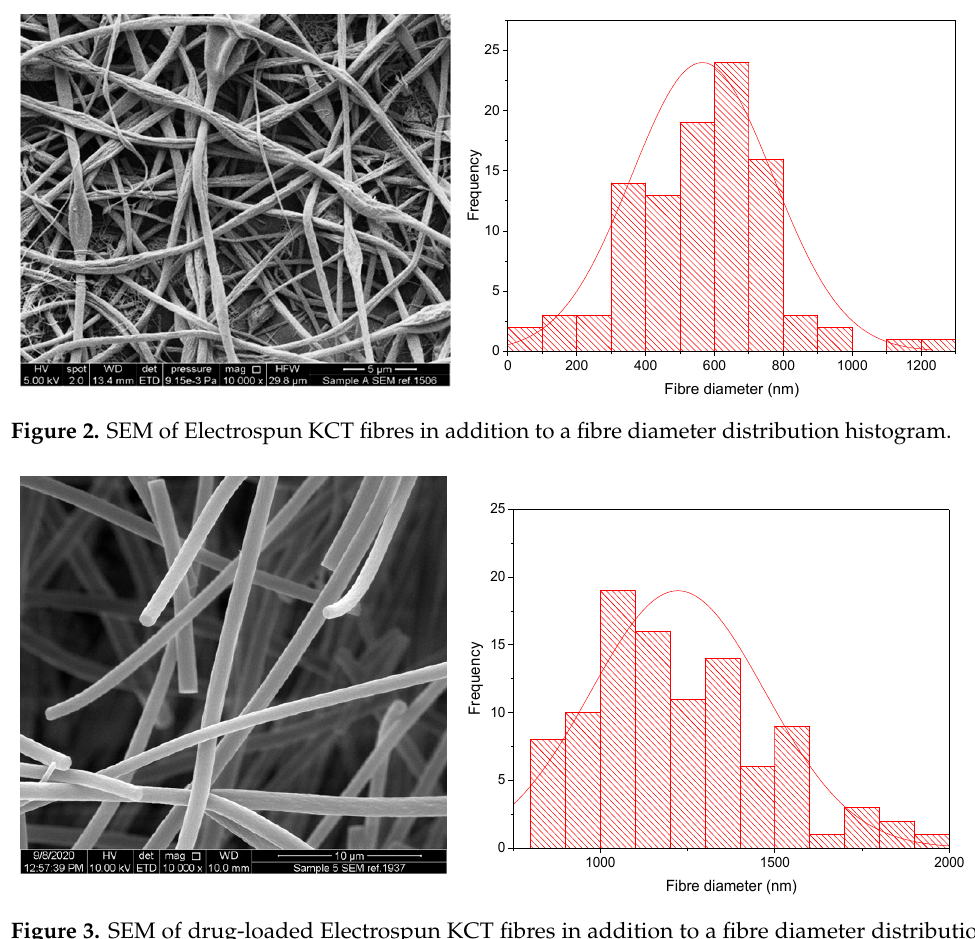
Figure 3. SEM of drug-loaded Electrospun KCT fibres in addition to a fibre diameter distribution histogram.